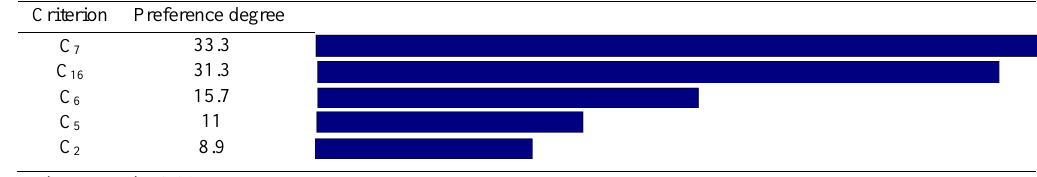
Table5. Comparison of proposed criteria importance to access the goal 20